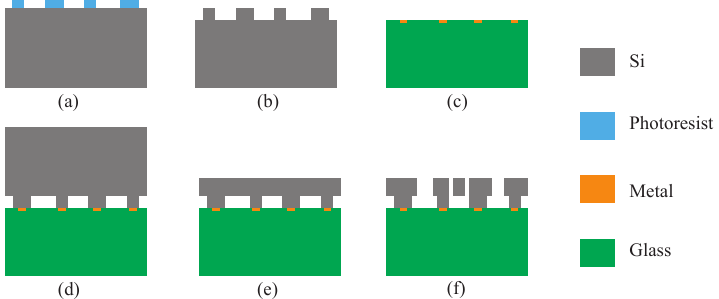
Figure 2. The fabrication process of the DRG: ( a ) photo-etching; ( b ) bonding area etching; ( c ) metal deposition; ( d ) anodic bonding; ( e ) thinning and polishing; ( f ) dry etching and structure